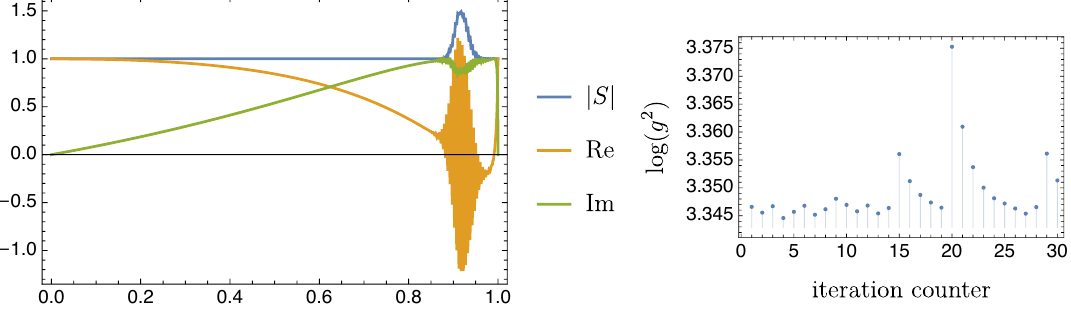
Figure 10 . An example of unstable behavior of Newton’s method with linear interpolations for = 3 . 981 after 30 m 2 z